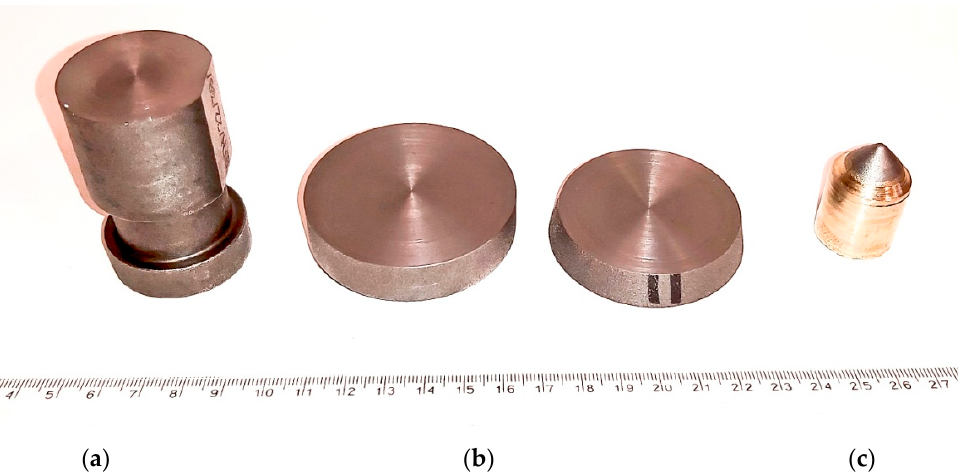
Figure 13. Examples of samples from a conical pick for material testing: ( a ) gripping part; ( b ) working part; ( c ) WC-Co